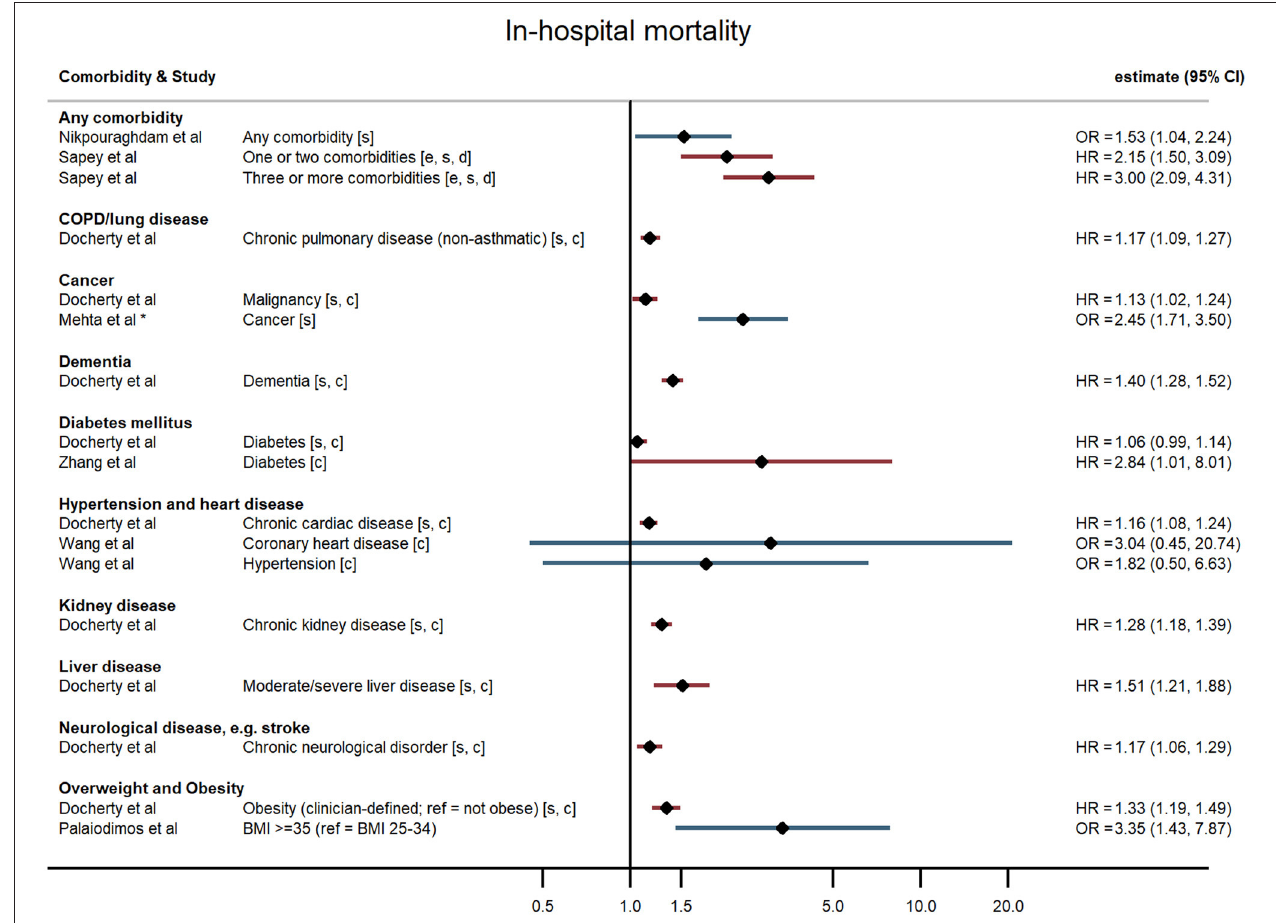
FIGURE 2 | Forest plot of study estimates of the association between comorbidities and COVID-19 mortality among hospitalized patients. Reference category for each comorbidity is the absence of that comorbidity, except where stated otherwise. HR, hazard ratio (red); OR, odds ratio (blue); CI, confidence interval; BMI, body mass index; COPD, chronic obstructive pulmonary disease. All estimates adjusted for age. Additionally adjusted for: sex [s]; other comorbidities [c]; ethnicity [e]; deprivation [d]. *95% CI not reported, but back-calculated from reported p